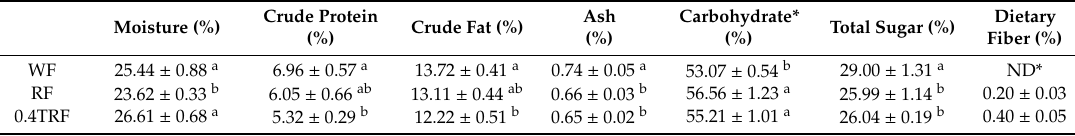
Table 2. Proximate composition of cake.